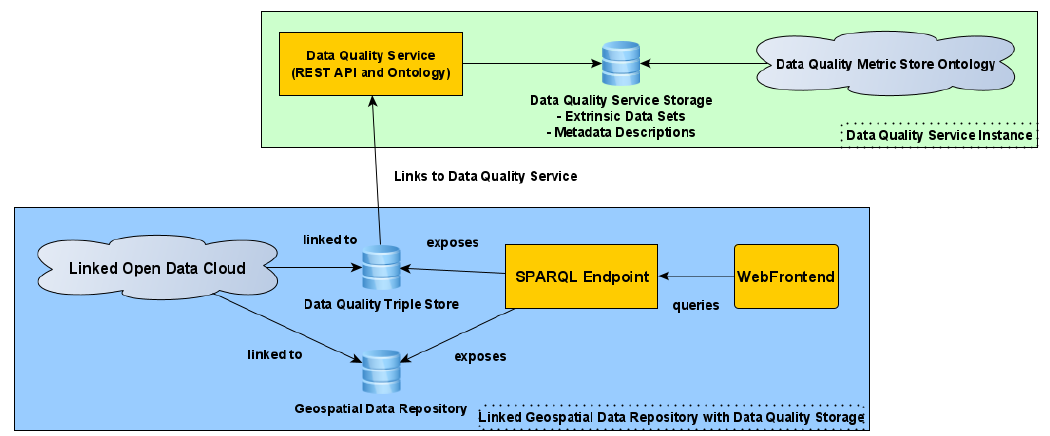
Figure 7. Architecture of the overall system: A data quality service provides semantically annotated data quality metric calculations which may be related to a situational description or thematic